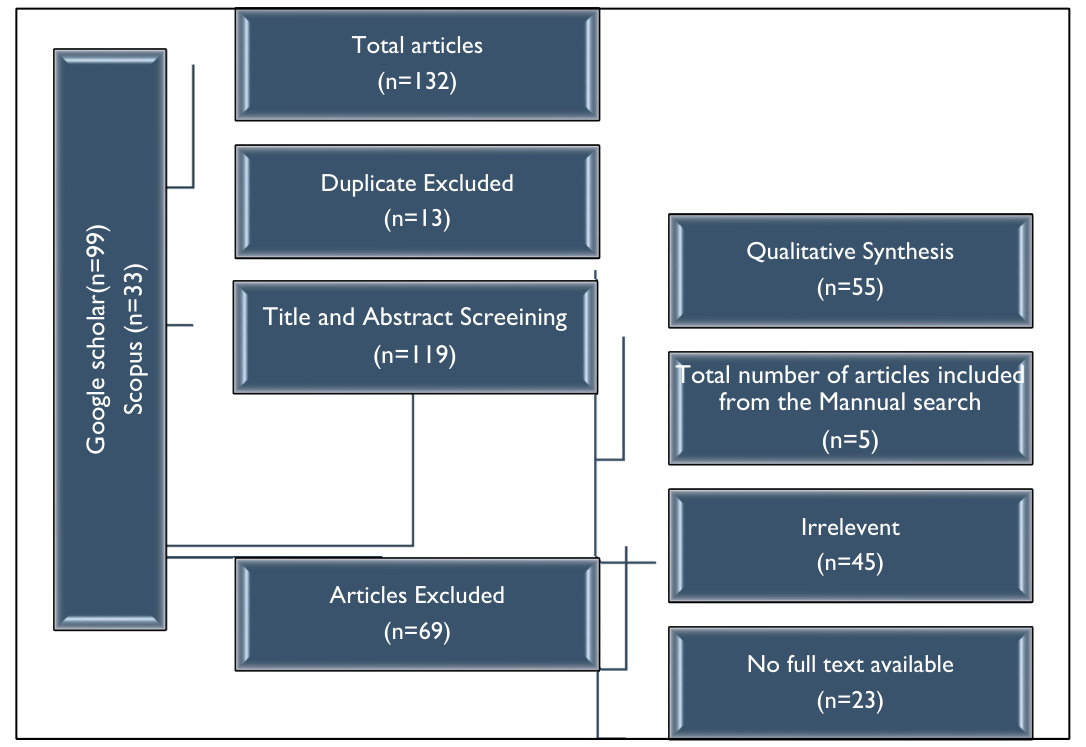
Figure 5. Flow diagram of studies’ screening and selection.